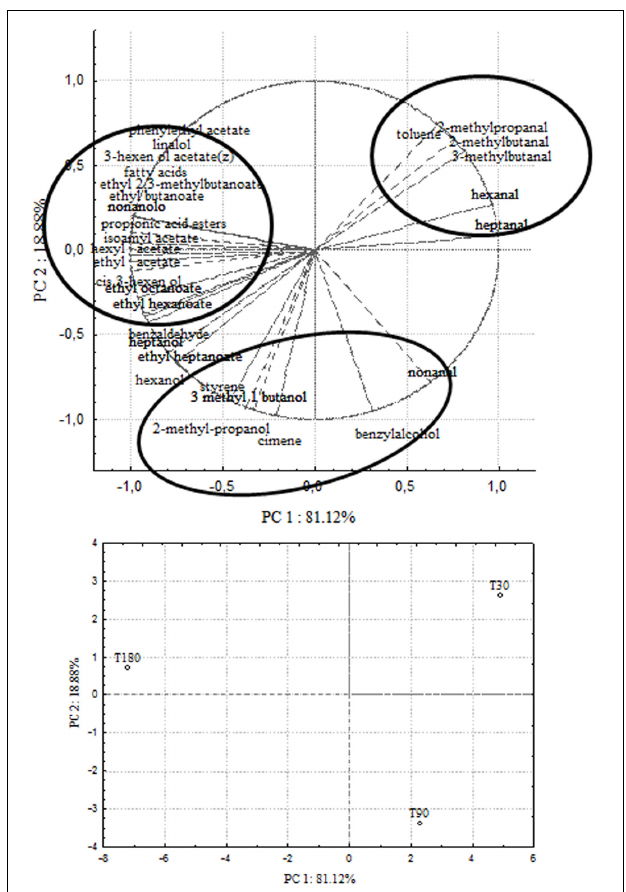
FIGURE 6 | PCA of volatile compounds associated with Leccino fermented table olives. Score plot of variables (concentration of